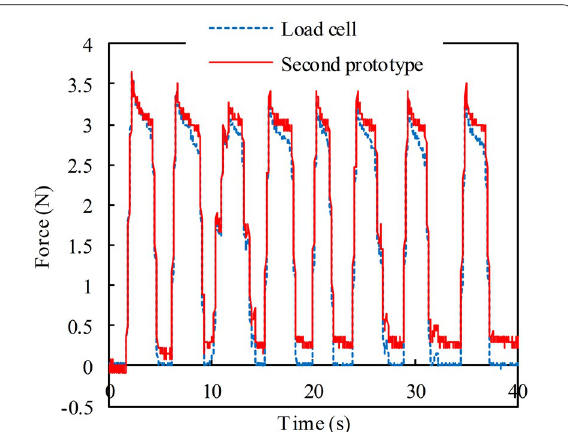
Fig. 13 Comparison of two forces measured by second prototype sensor and load cell when a random force was applied ( T < T g , Fig. 11 Relationship between applied force and strain on steel plate h T 0.05 mm). Substituting the strain measured by the prototype (second prototype): a h T 0.05 mm, b h T 0.1 mm, c h T 0.3 mm. = = = = sensor into the linear approximation formula in Fig. 11a, we The alternate long and short dash lines show linear approximation. The linear approximation formulae are also shown